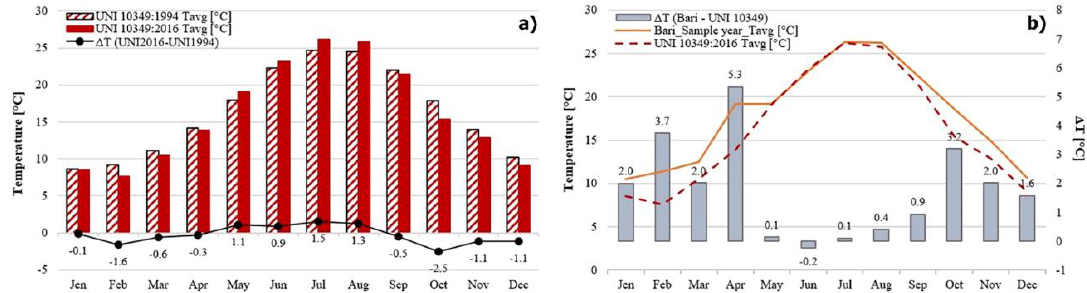
Figure 10. Figure 10. ( a ) Comparison between UNI 10349:1994 and UNI 10349:2016 temperature data; ( b ) Comparison between the sample year and UNI 10349: 2016 temperature data.